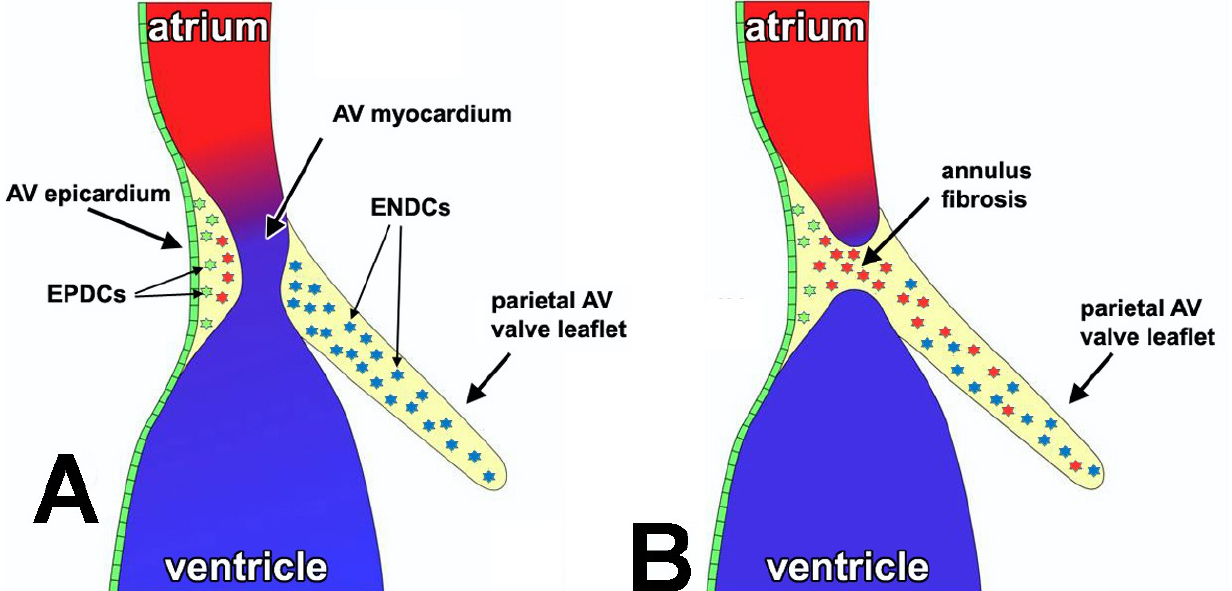
Figure 3. Schematic representation of the contribution of the AV epicardium and the epicardially-derived cells to the development of the AV junction. After formation of the epicardial epithelium (green), epiEMT generates a population of AV-EPDCs (green cells in panel A) that, as far as their gene expression profile is concerned, are still very similar to the epicardium itself. However, when the AV-EPDCs migrate further into the AV sulcus and approach the AV myocardium (red cells), the molecular profile of the AV-EPDCs changes drastically as the expression of genes characteristically found in the mesenchyme of the annulus fibrosus (e.g., MMP2) and the AV cushions (e.g., Sox9) is upregulated. These “differentiated” AV-EPDCs (red cells in panel A) then penetrate the AV myocardium to form the annulus fibrosus (panel B) and migrate into the parietal AV valve leaflets where they intermingle with the endocardially-derived mesenchymal cells (ENDCs; blue cells in panels A and